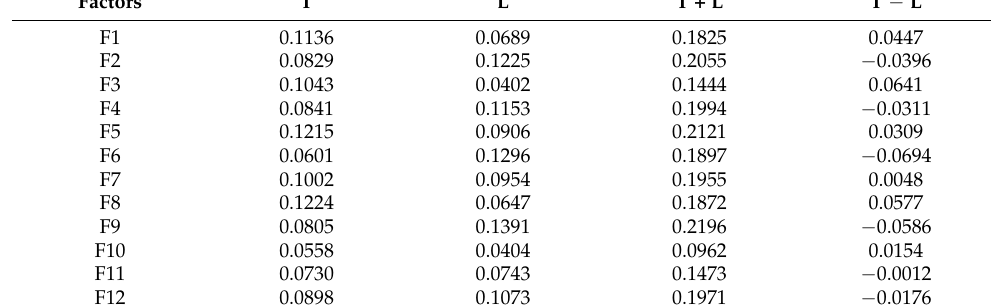
Table 12. Prominence and relation of value elements.